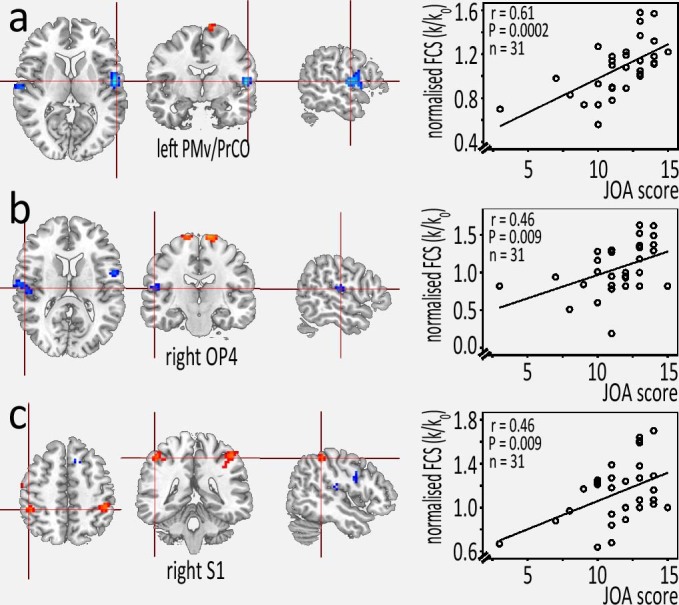
Correlation between the JOA score and the mean-normalized FCS in the left PMv/PrCO, right OP4, and right S1 (representation of the hand) in CSM patients.